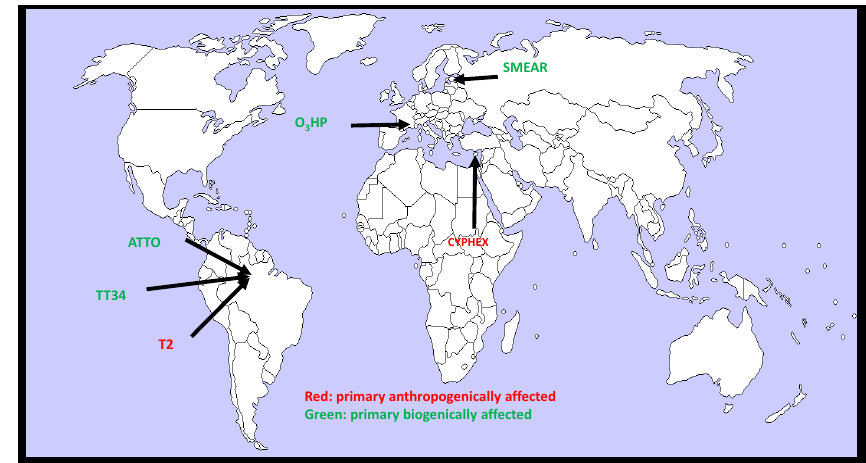
Figure 1. World map showing the location of the different sites. The names are colour-coded to show whether they have primarily biogenic influence (green) or a primarily anthropogenic influence (red). Source: outline world map, http://www.outline-world-map.com/ political-white-world-map-b6a, last access: 1 September